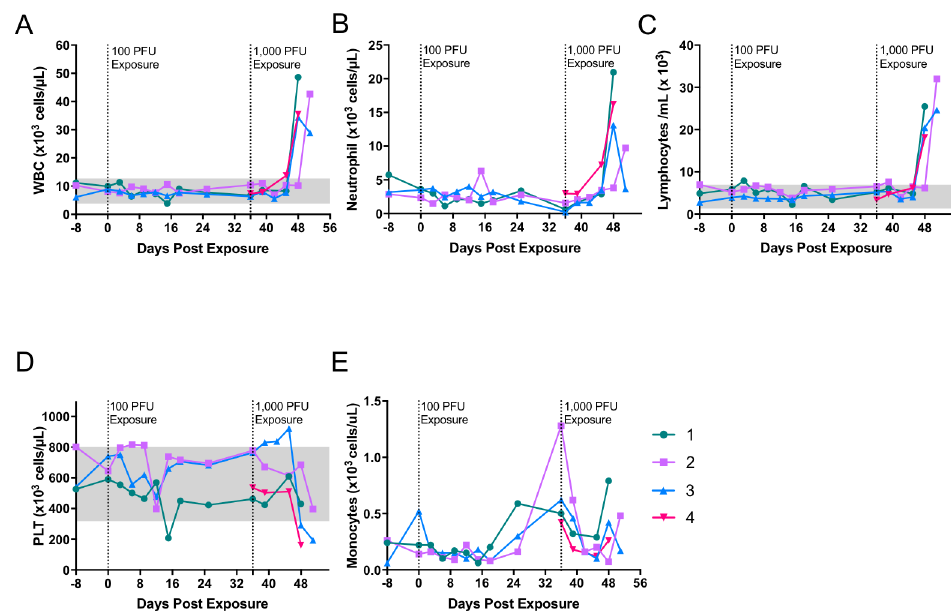
Fig 2. Hematology of marmosets intranasally exposed to monkeypox virus. Marmosets were exposed to 100 pfu (days 0) and later exposed (day 36) with 1000 pfu (animal #s 1, 2, and 3). Concomitantly, a na ï ve animal (#4) was exposed to 5,000 pfu of monkeypox virus. White blood cells (WBC) (A), neutrophils (B) and lymphocytes (C) all increased above baseline values, whereas platelets (PLT)(D) tended to drop. Monocytes (E) tended to initially drop after exposure, but rebounded or increased between days 9–15 post exposure. Data suggest that animals were not infected with 100 pfu, but were at the two higher doses. Shading represents in-house normal values for each parameter (Mucker, et al. 2015). Data was acquired using a Hemavet HV950.